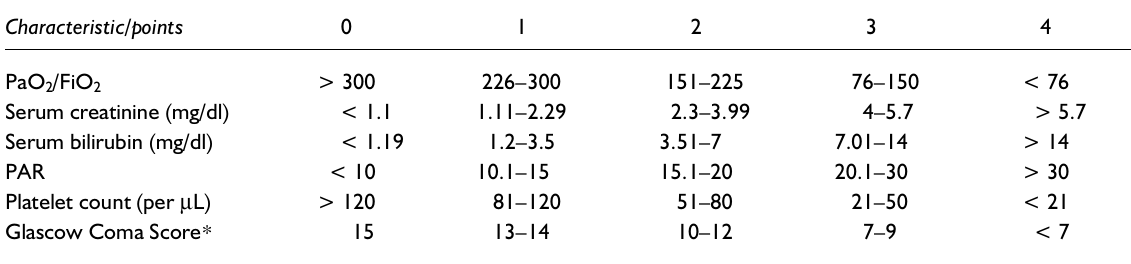
Table 5 The Multiple Organ Dysfunction Score (MODS); PAR, pulse-adjusted heart rate = HR x (RAP/MAP); HR, heart rate; RAP, right atrial pressure; MAP, mean arterial pressure; * the best estimate in the absence of sedation